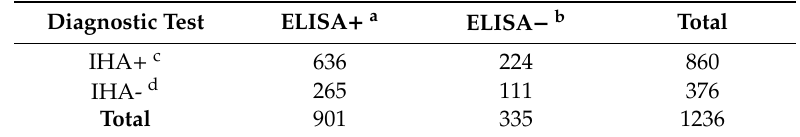
Table 2. Cross-classified test results for hemorrhagic septicemia in 1236 dairy cows from ELISA and IHA tests.